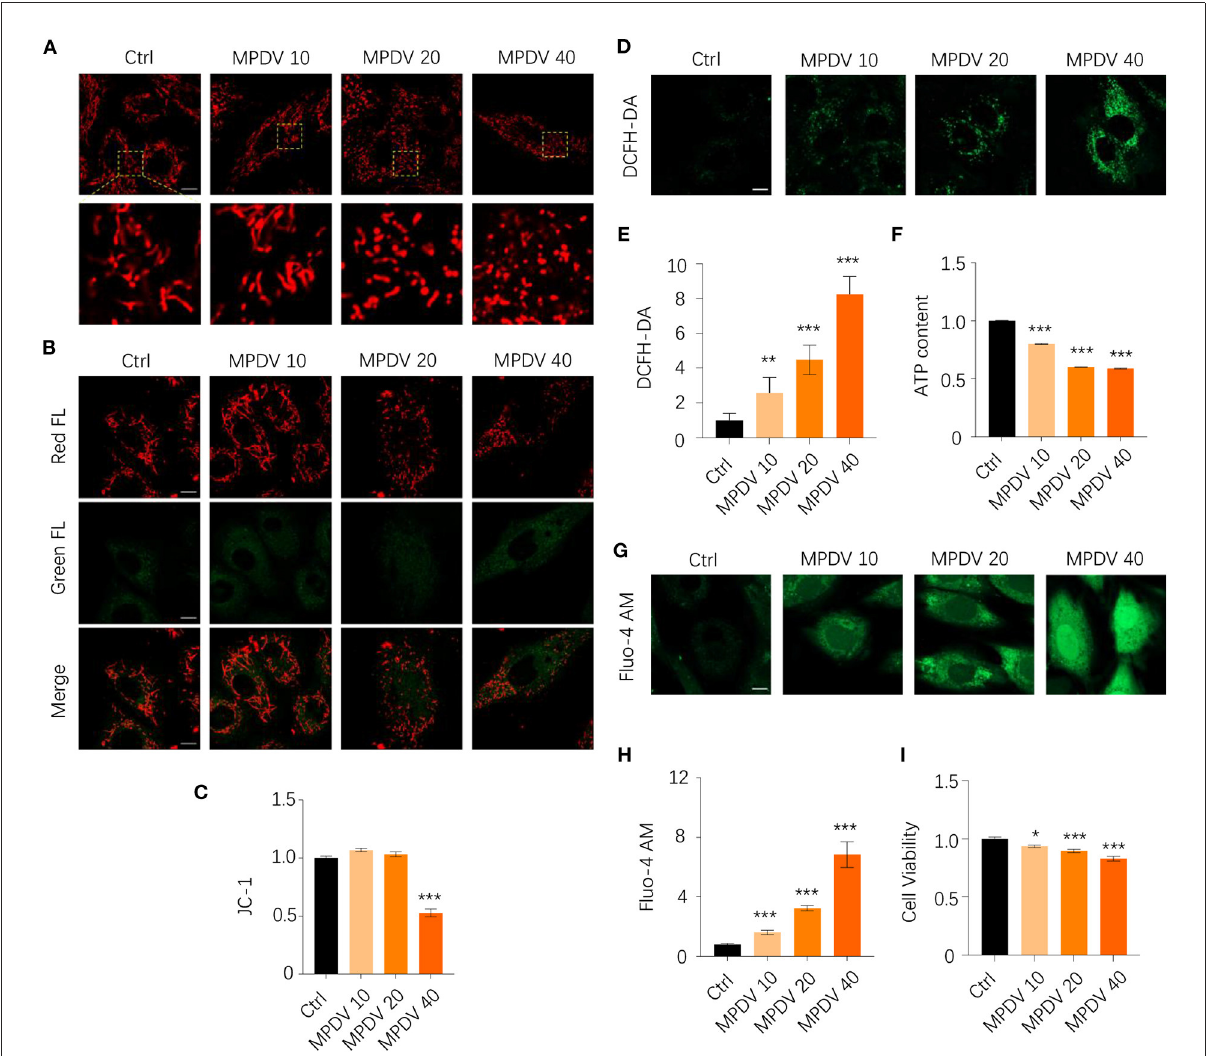
FIGURE5 MPDV treatment is detrimental to mitochondrial biological functions and cell viability. (A) H9c2 cardiomyocytes were treated with MPDV (0, 10, 20, and 40%) for 24h. Mitochondrial morphology was observed by Zeiss 800 confocal microscopy with 63 × oil objective by using Mitotracker staining dye with red fluorescence. Magnified photographs showed a detailed view of the yellow area indicated in the upper panels. (B,C) Mitochondrial membrane potential was observed by Zeiss 800 confocal microscopy with 63 × oil objective by using JC-1 staining dye with both red and green fluorescence. The ratio of red/green FL was calculated by the fluorescence microplate assay. (D,E) ROS level was observed by Zeiss 800 confocal microscopy with 63 × oil objective by using DCFH-DA staining dye. The green FL was calculated from different views. (F) ATP production is detected by the luminescent detection assay in 96 well white/clear bottom plates. (G,H) Calcium level was observed by Zeiss 800 confocal microscopy with a 63 × oil objective using DCFH-DA staining dye. The green FL was calculated from different views. (I) Cell viability is detected by MTT assay. Data ( n = 6) were shown as the mean ± SEM ( * p < 0.05, ** p < 0.01, *** p < 0.001). Scale bar: 10 µ m.